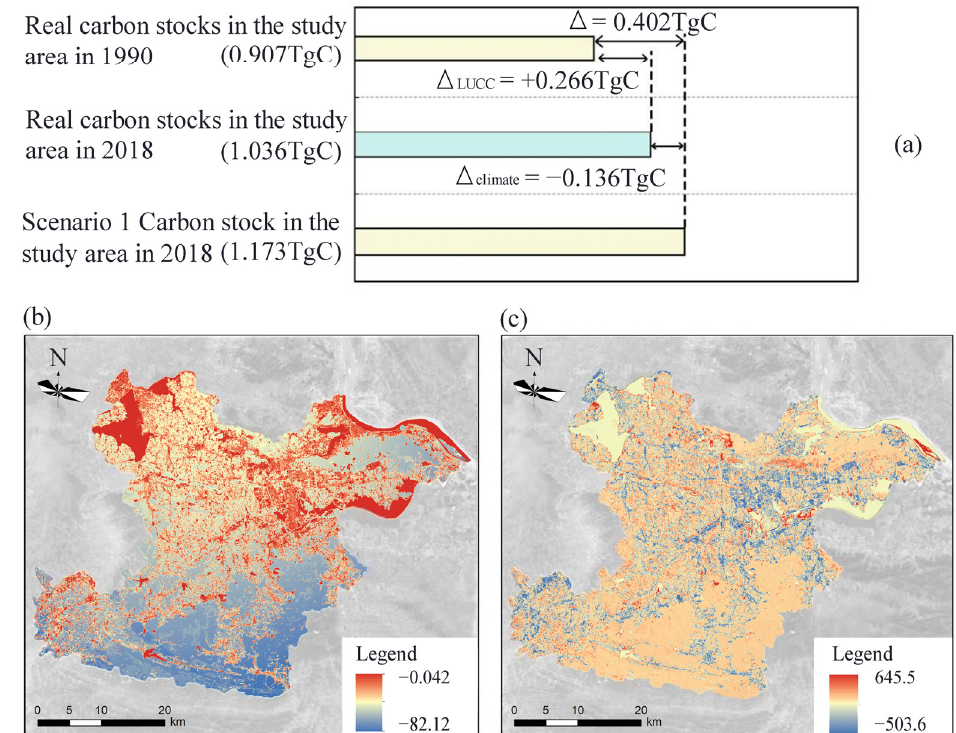
Figure 6. Scenario analysis for climate and landscape pattern changes ( a ), the impact of climate change on NPP ( b ), and the impact of landscape pattern evolution on NPP ( c ).